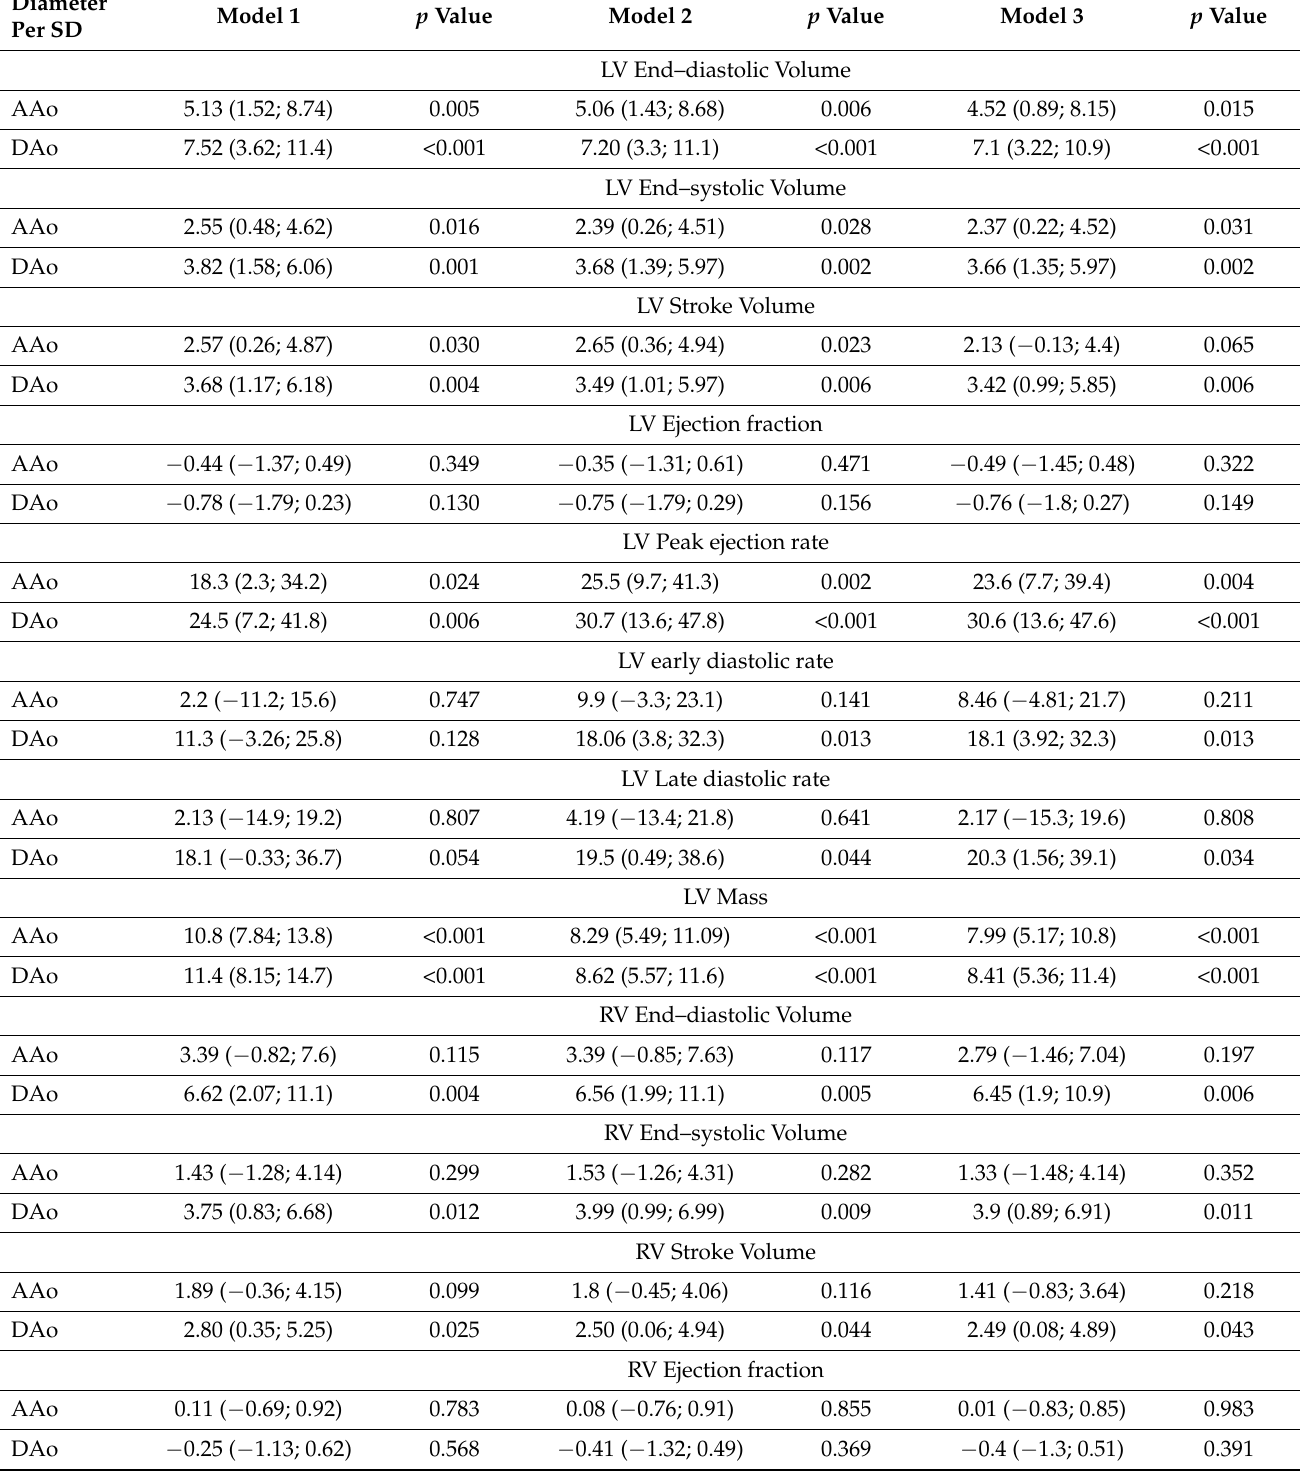
Table 2. Association between Diameter of the aorta and ventricle function